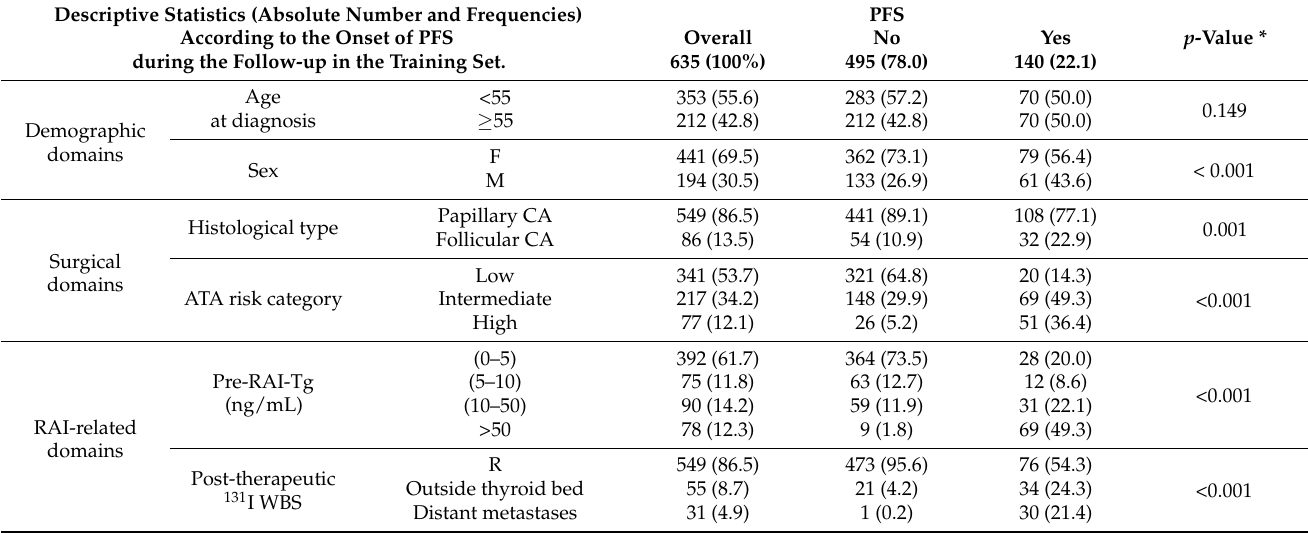
Table 2. Association between each parameter of the three domains and progression-free survival. Descriptive Statistics (Absolute Number and Frequencies) According to the Onset of PFS during the Follow-up in the Training Set.